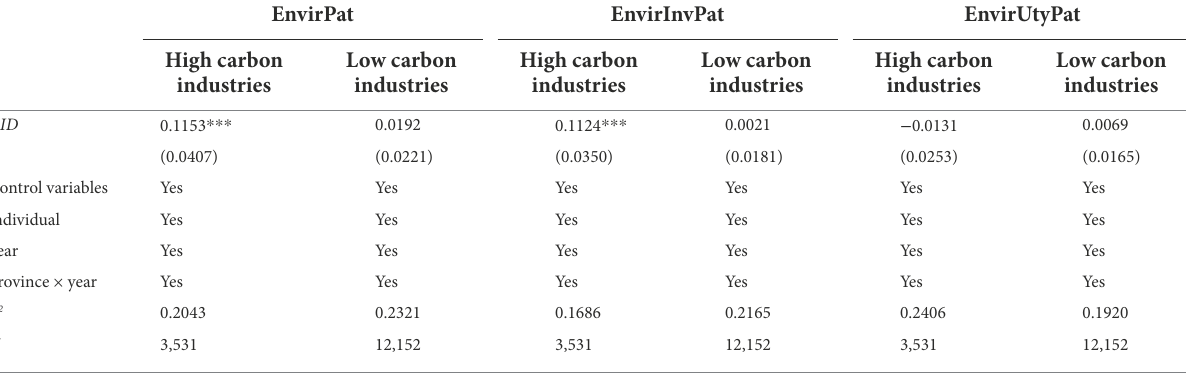
TABLE 10 The heterogeneity of industry.